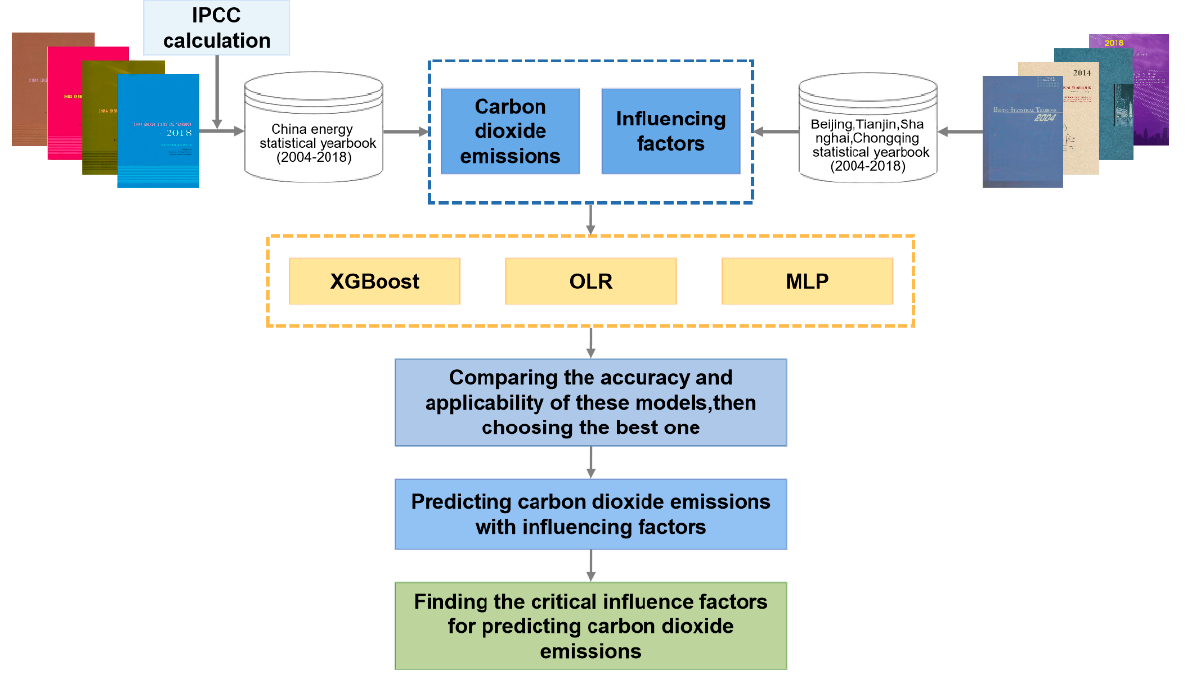
Figure 1. Workflow for the detection of influencing factors related to CE of urban expansion.